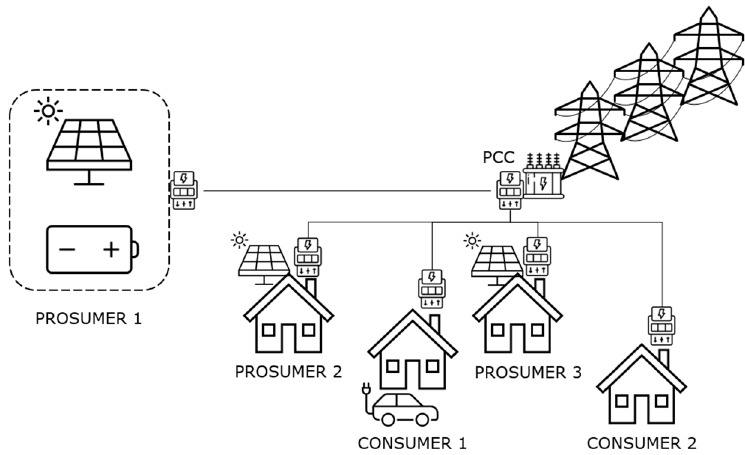
Figure 3. LEC organised as Community for Flexibility Aggregation.